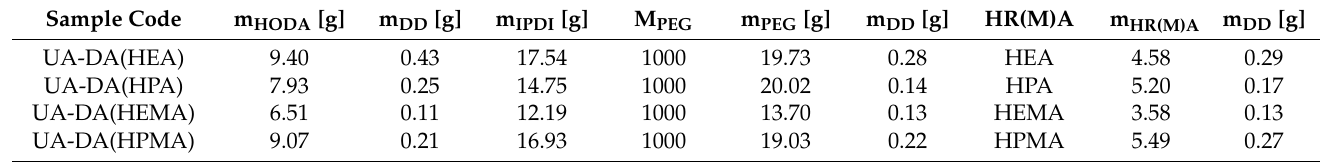
Table 1. Summary of the amounts of substrates used in the